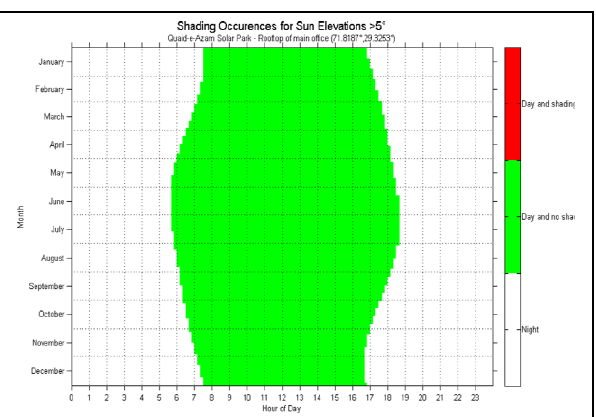
Fig. 13. Shadow effect of QASPP and Crest energy [18]